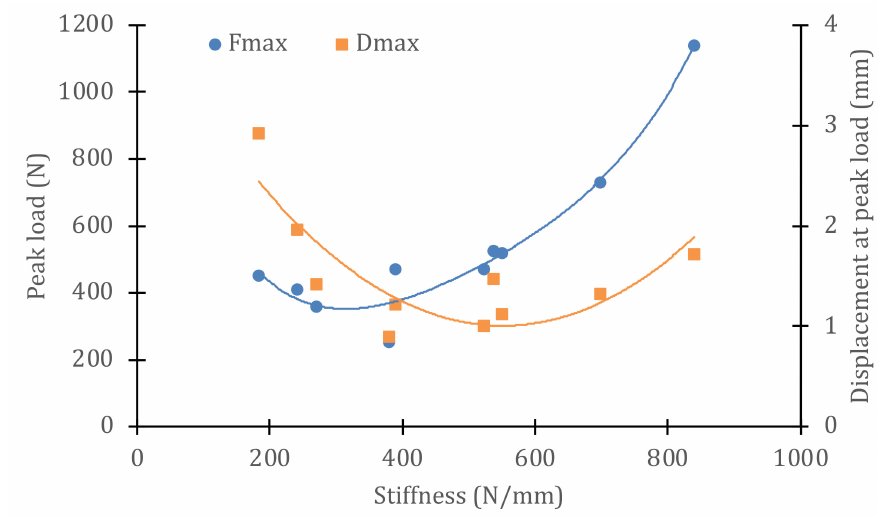
Figure 10. Variation in strength and displacement at maximum load as a function of specimen stiffness, after 900,000 impact cycles, under dry/wet conditions.